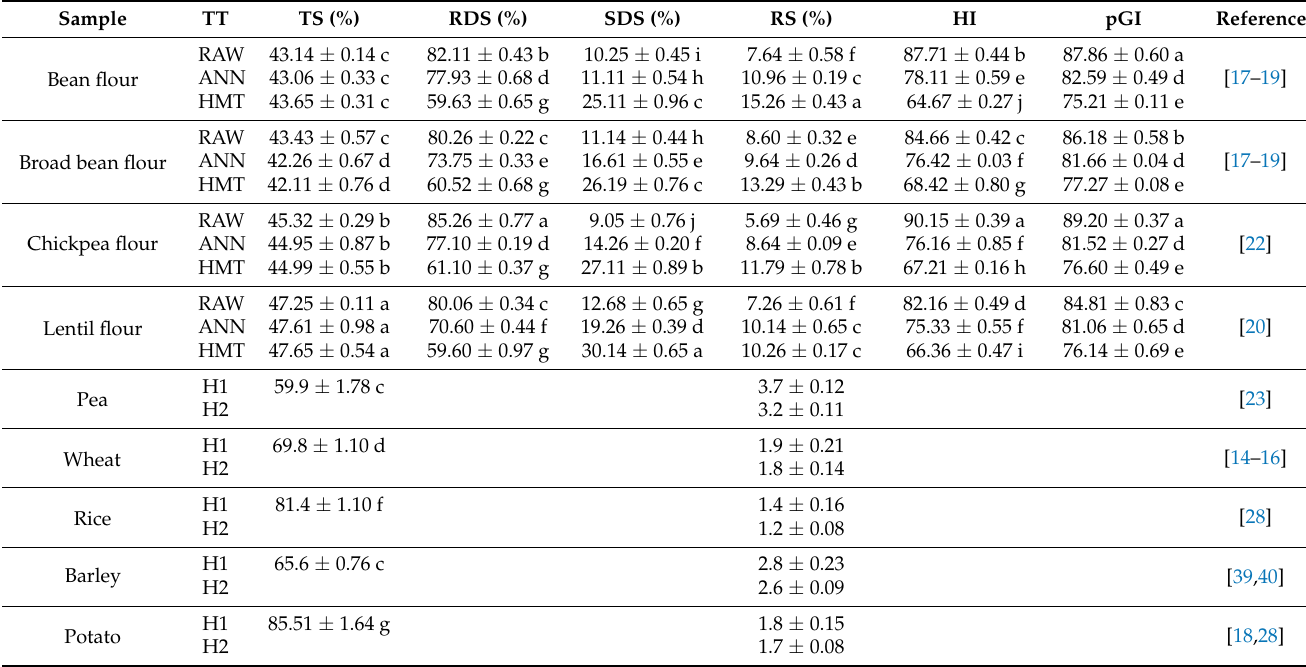
Table 2. Resistant starch in grains and